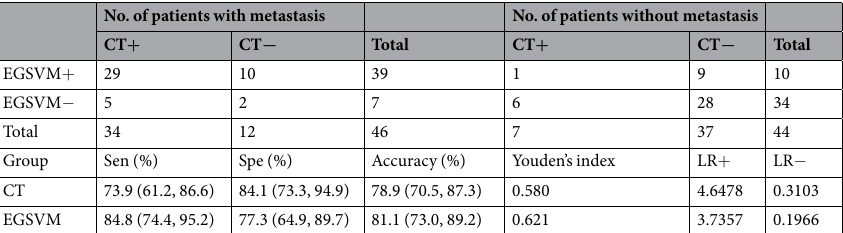
Table 4. Comparison of diagnostic efficacies between contrast-enhanced CT and the EGSVM-based infrared thermal imaging system. Data in parentheses are 95% CIs; CT + = positive at contrast-enhanced CT; CT − = negative at contrast-enhanced CT; EGSVM + = positive at EGSVM-based infrared thermal imaging system; EGSVM − = negative at EGSVM-based infrared thermal imaging system; Sen = sensitivity; Spe = specificity; LR + = positive likelihood ratio; LR − = negative likelihood ratio.